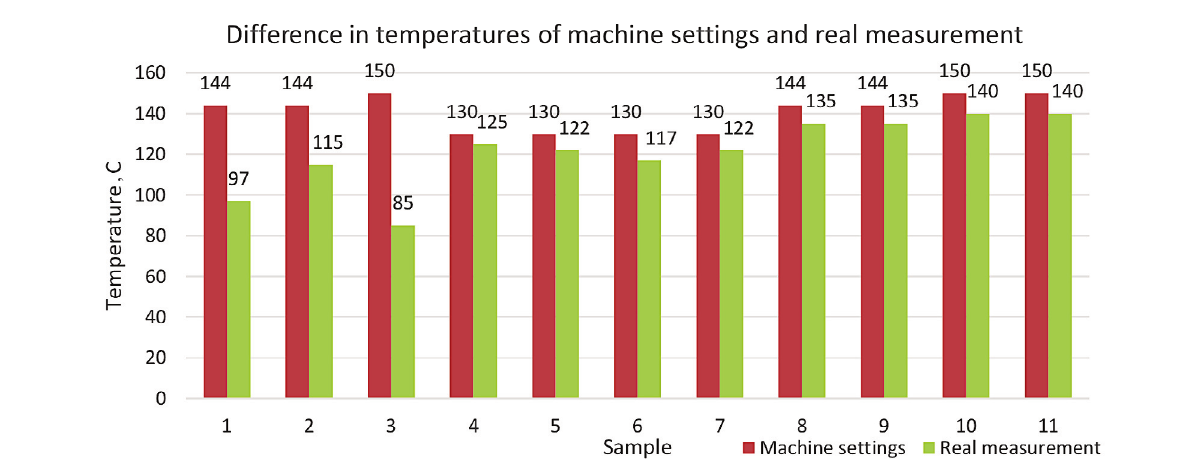
Fig. 3. Difference between machine measured temperature against real measurement from the module